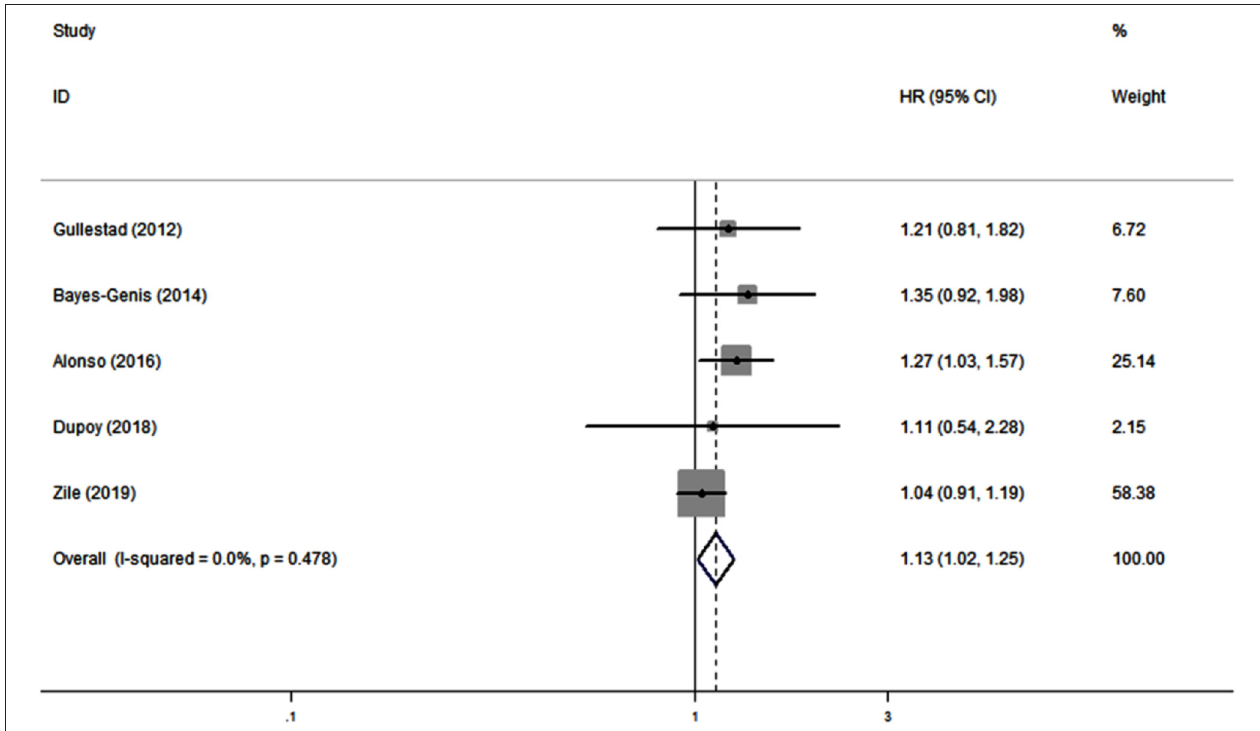
FIGURE 4 | Meta-analysis of the association between galectin-3 and risk of CVD in CHF patients. Results are presented as individual and pooled HR, and 95% CI.